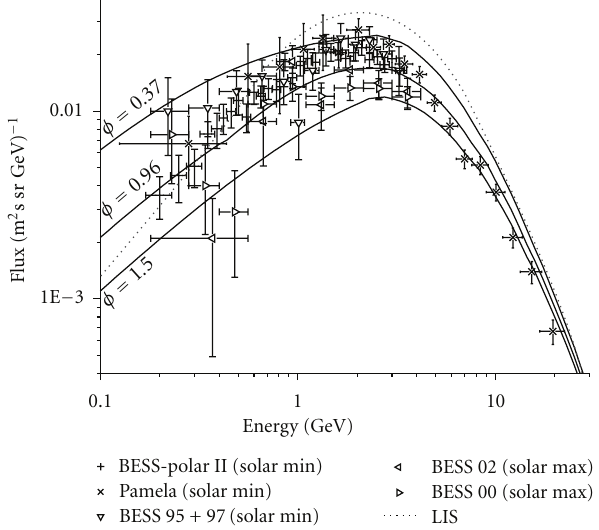
Figure 5: Simulated LIS and the modulated spectra compared with experimental observations during the di ff erent phase of solar cycles: BESS 95 + 97 [19]; BESS 00 [20], BESS 02 [21], BESS-Polar II [22], and PAMELA [4]. “Force field” parameter Φ in